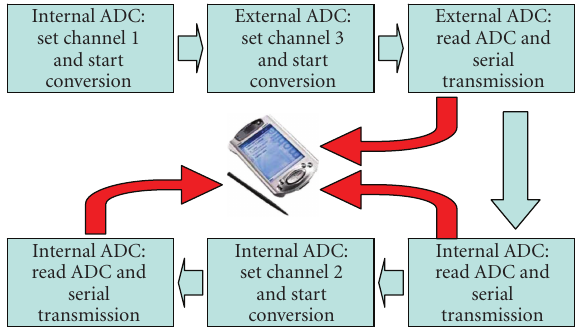
Figure 2: A sensing unit.